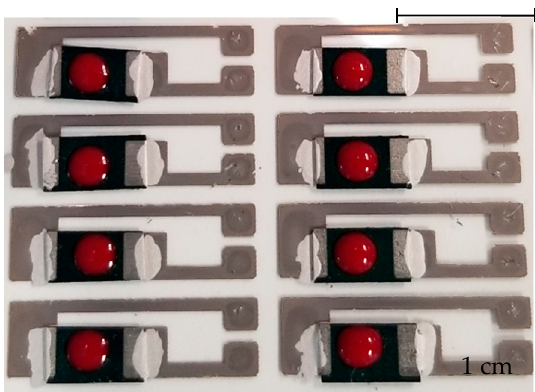
Figure 7. Photographic image of the paper sensor array devices after dispensing blood solution containing glucose.